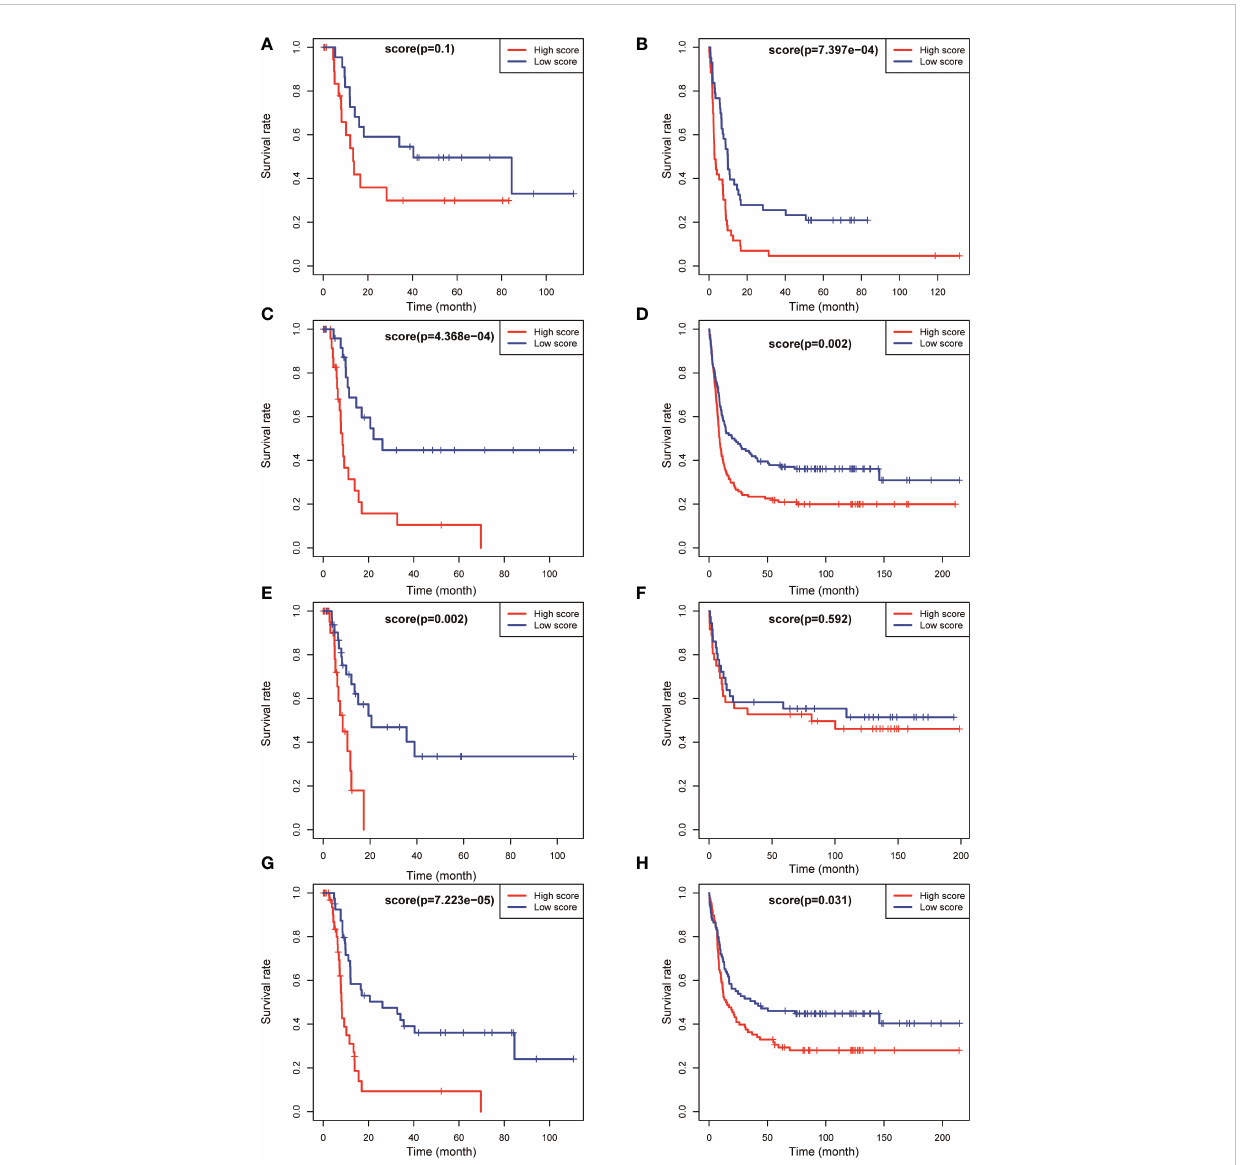
FIGURE 5 Kaplan – Meier survival analysis of EFS for patients in different NCCN risk strata was performed based on high and low risk scores. EFS of the favorable-risk subgroup in TCGA (A) and GSE6891 (B) ; EFS of the intermediate-risk subgroup in TCGA (C) and GSE6891 (D) ; EFS of the poor-risk subgroup in TCGA (E) and GSE6891 (F) ; and EFS of the normal-karyotype subgroup in TCGA (G) and GSE6891 (H)